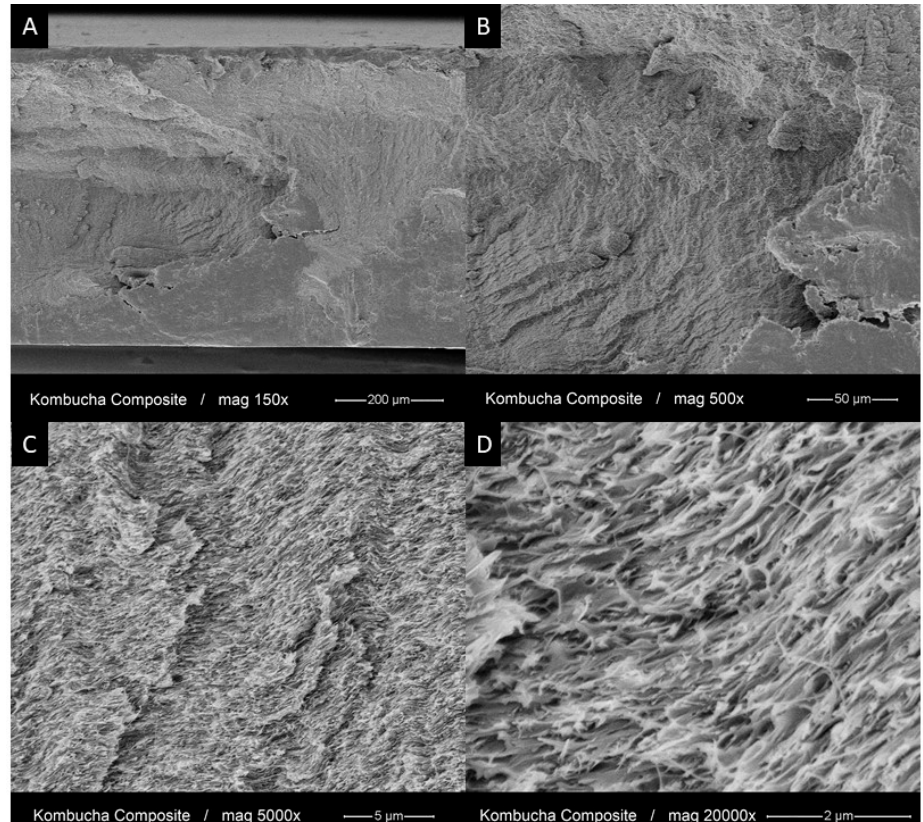
Figure 7. SEM images of the fracture cross-section of the PMMA-KBC nanocomposite at different magnifications. ( A , B ) overview micrographs showing brittle fracture of the nanocomposite. ( C , D ) detailed views of the nanocomposites with the visible fibrils and intact KBC network at the cross-section.